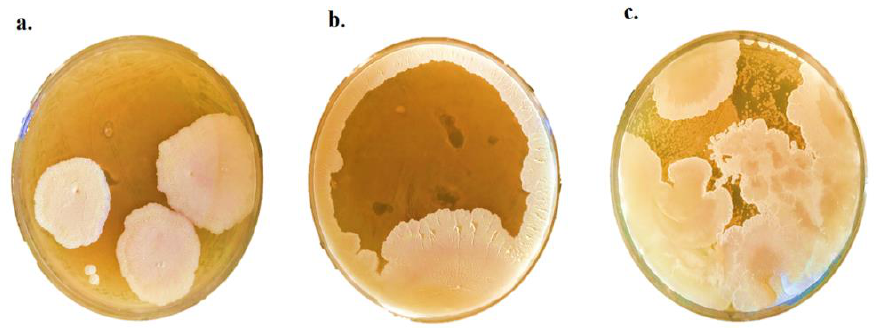
Figure 3. Antifungal activity of P. pentosaceus against A. ochraceus ( a ), P. verrucosum ( b ) and F. gra- minearum ( c